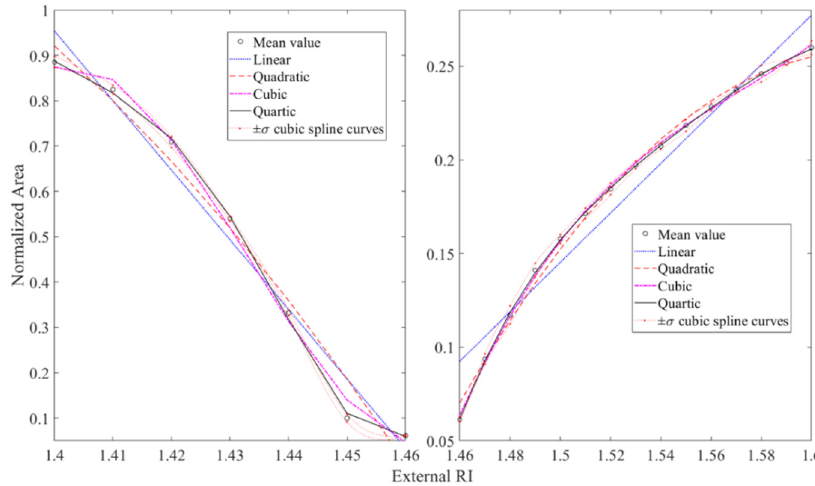
Figure 12. Fitting correlation functions with α = 2 along the RI range.